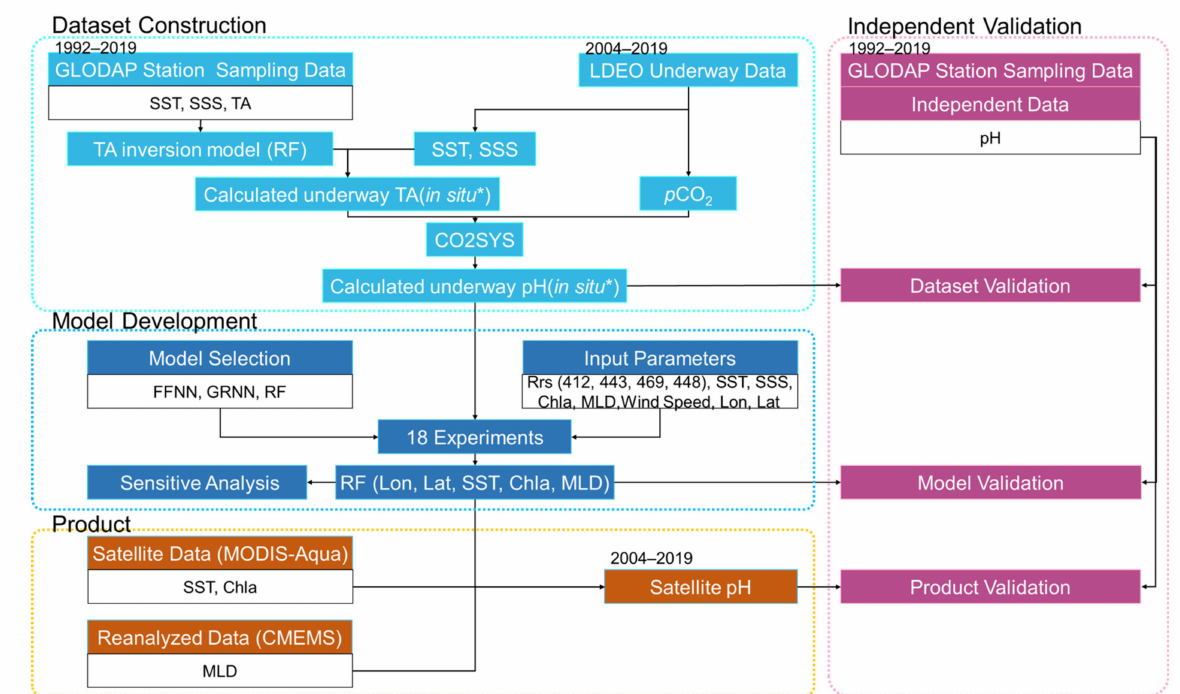
Figure 3. Flowchart of pH remote sensing inversion. In situ * means to treat the calculated data as the ground truth